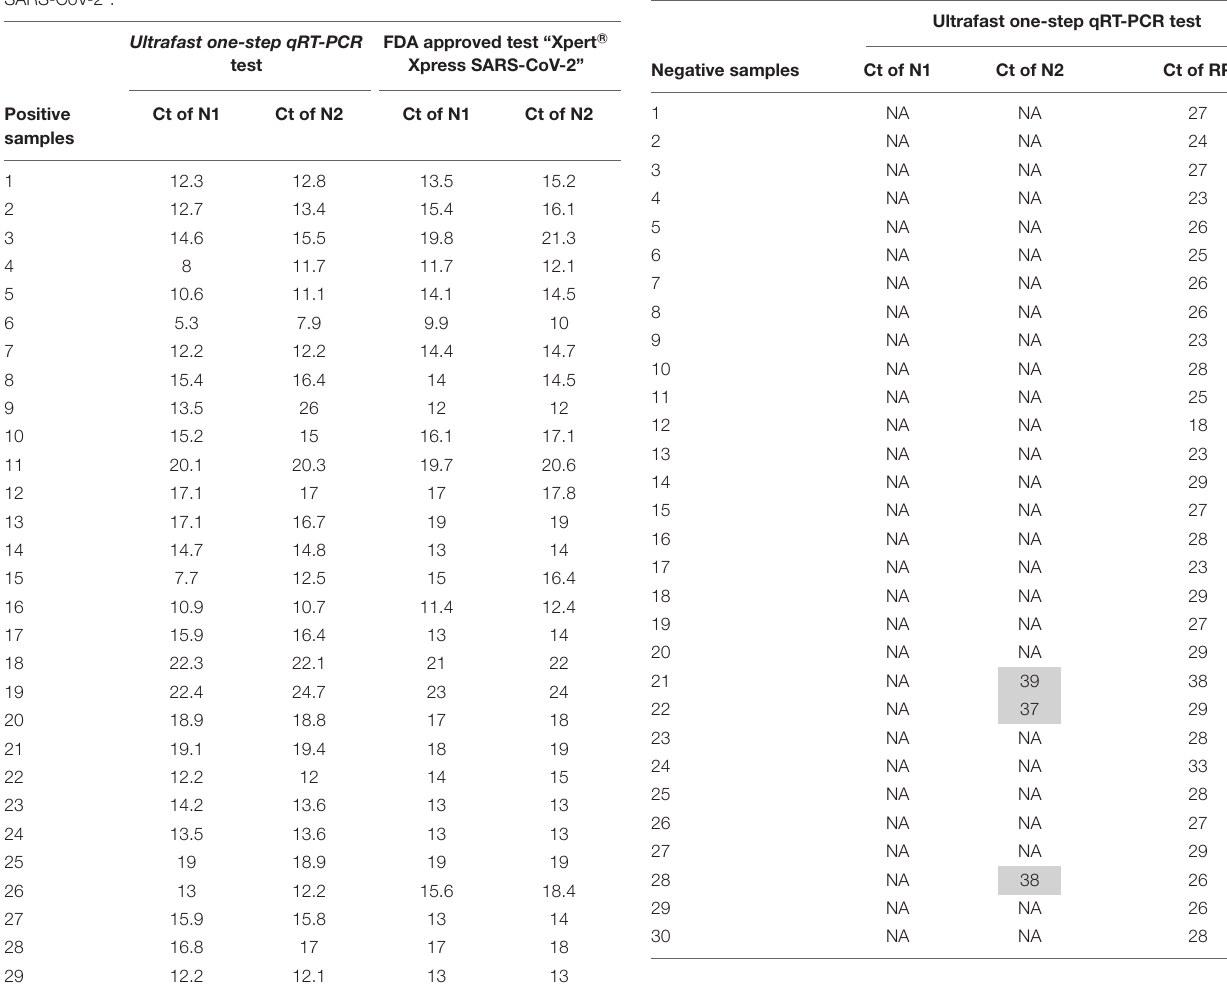
TABLE 4 | Cycle threshold (Ct) value of SARS CoV-2 negative samples of the ultrafast one-step qRT-PCR.